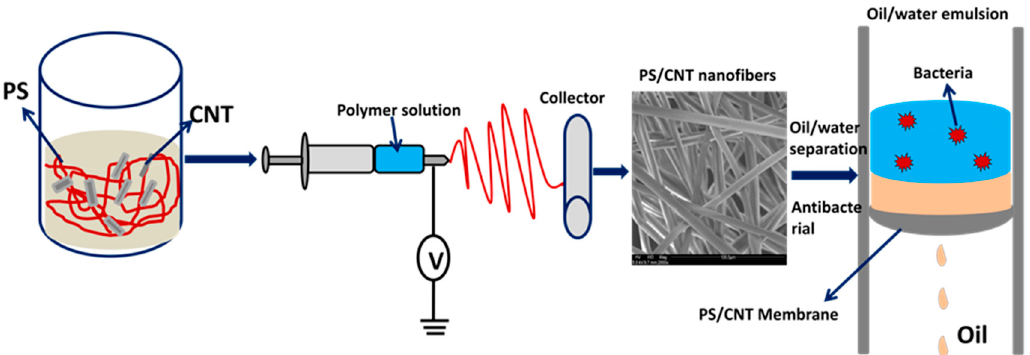
Figure 1. Schematic representation of the fabrication of polystyrene (PS)/carbon nanotubes (CNTs) antibacterial nanofibers and its application in oil/water separation.